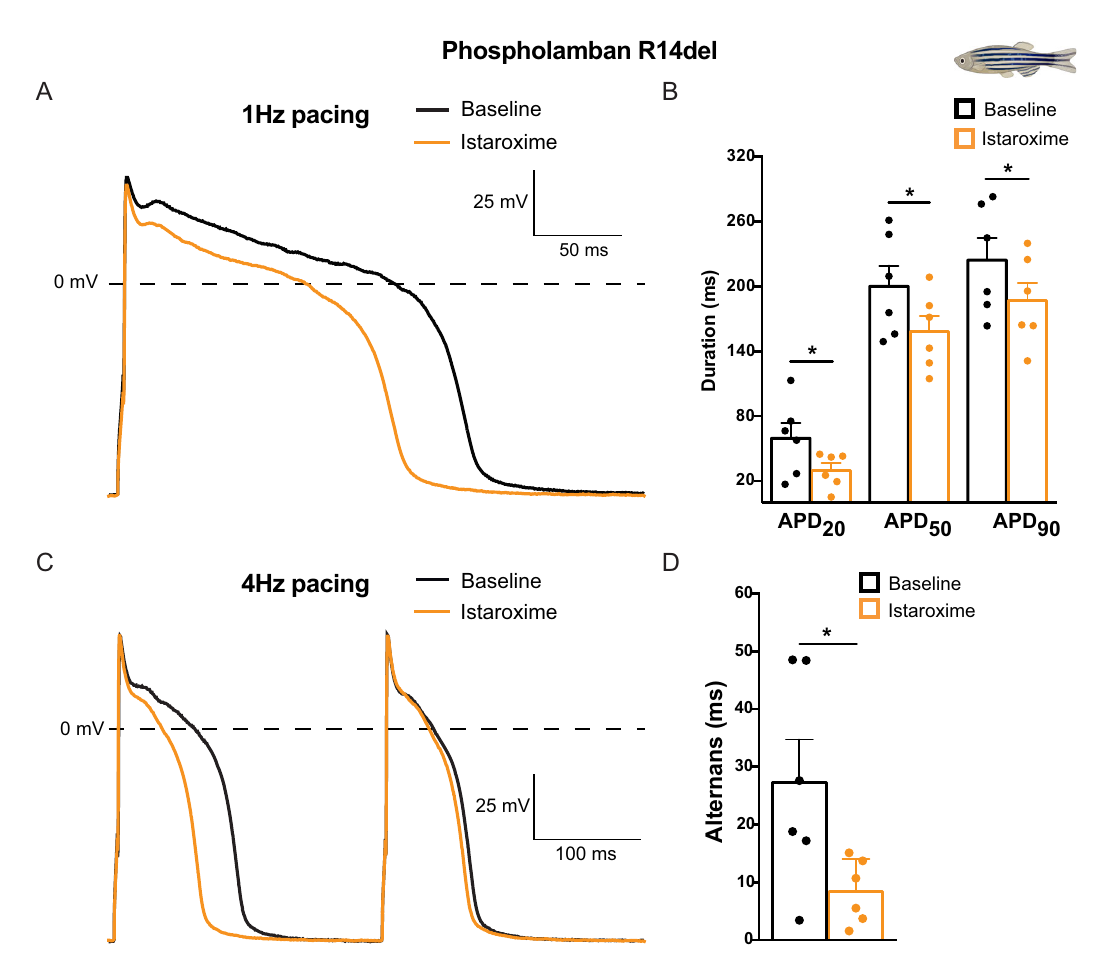
Fig. 7 Istaroxime reverses action potential alternans in plna R14del isolated adult cardiomyocytes. A Typical action potentials (APs) of plna R14del isolated adult cardiomyocytes at baseline (black line) and after incubation with 5 µ M istaroxime (orange line), paced at 1 Hertz (Hz). B Average AP parameters of plna R14del isolated adult cardiomyocytes at baseline (black bars) and after incubation with 5 µ M istaroxime (orange bars), at 1 Hz pacing (mean ± SEM, APD 20 : * p = 0.030, APD 50 : * p = 0.022, APD 90 : * p = 0.020, baseline n = 6, istaroxime n = 6, paired Student ’ s t -test). C Typical action potentials (APs) of plna R14del isolated adult cardiomyocytes at baseline (black line) and after incubation with 5 µ M istaroxime (orange line), paced at 4 Hz. The plna R14del cardiomyocyte showed an AP alternans at baseline, where a long AP is followed by a short AP. D Average APD 90 difference between two consecutive APs (alternans) at baseline and after incubation with 5 µ M istaroxime, during 4 Hz pacing (mean ± SEM, * p = 0.039, baseline n = 6, istaroxime n = 6, paired Student ’ s t -test). All measurements were performed in three experimental replicates. Baseline condition is highlighted in black and treated in orange. Hz Hertz, mV millivolt, APD 20 AP duration at 20% of repolarization, APD 50 AP duration at 50% of repolarization, APD 90 AP duration at 90% of repolarization. Source data are provided as a Source Data fi